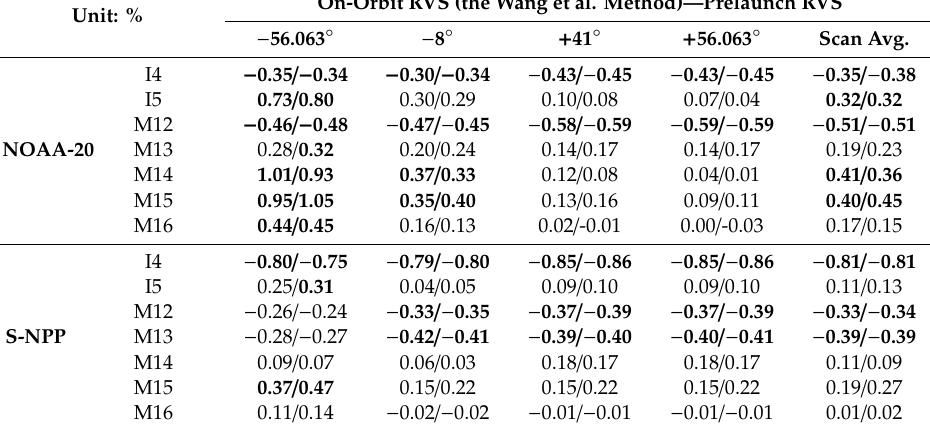
Table 3. NOAA-20 and S-NPP band-averaged di ff erences between the Wang et al. method derived on-orbit RVS and prelaunch RVS over scan angles at − 56.063 ◦ (EVBOS), − 8 ◦ (OBCBB AOI), + 41 ◦ , + 56.063 ◦ (EVEOS), and averaged over the entire EV scan angles (Scan Avg.), for HAM-A and HAM-B. Cases with di ff erences exceeding ± 0.3% are